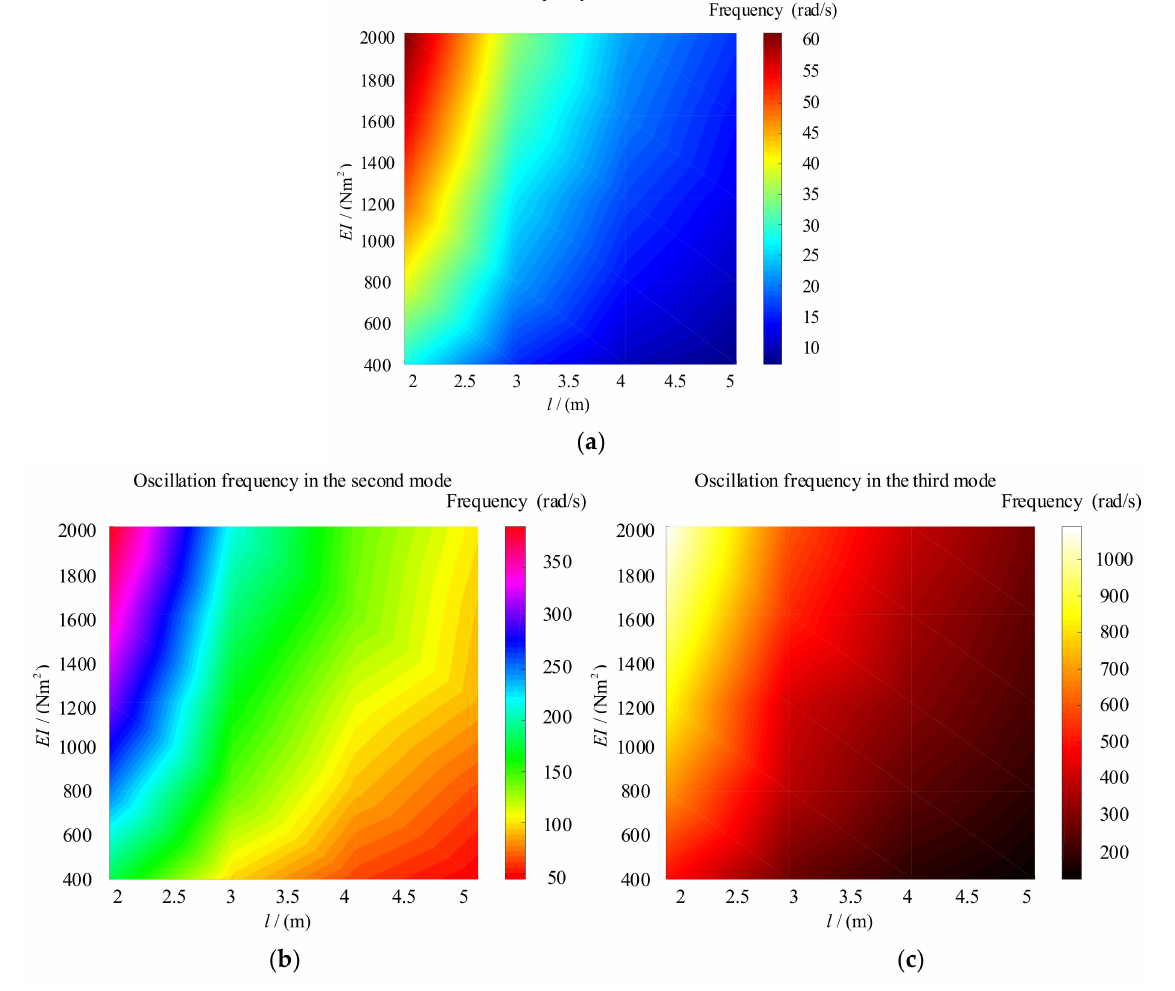
Figure 4. Distribution of the oscillation frequency. ( a ) The first mode. ( b ) The second mode. ( c ) The third